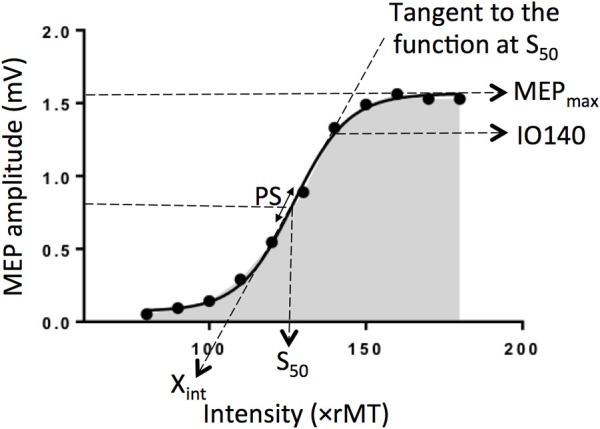
Electrophysiological parameters extracted from an example of an input output curve (I/O curve) fitted by a sigmoid function. Are shown the following variables: Xint: X intercept, IO140: Motor Evoked Potential amplitude recorded at 140% rMT, PS, peak slope; AUC, area under the I/O curve in gray; S50, stimulus intensity needed to obtain 50% of the maximum response; MEPmax, maximum value of the sigmoid function.